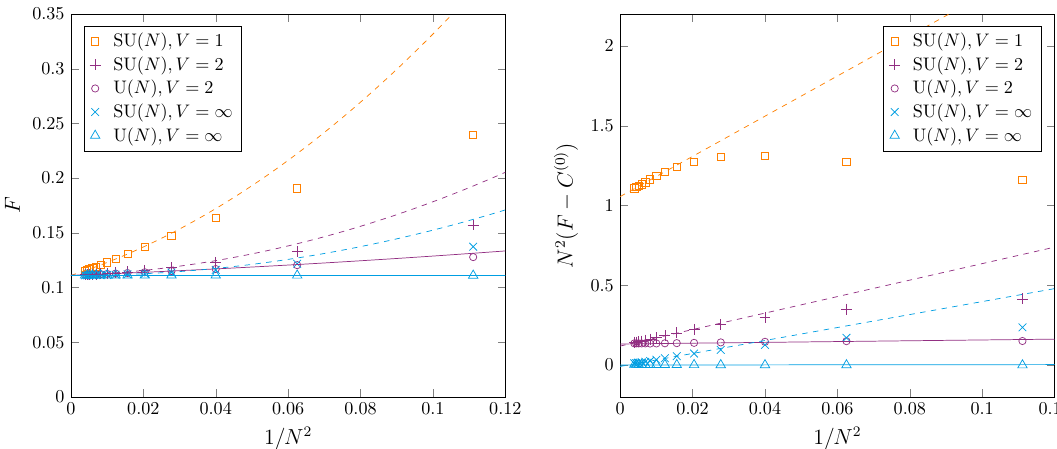
Figure 12 . (Left) The free energy density F is plotted against 1 /N 2 for the U( N ) and SU( N ) gauge theories at λ = 3 with V = 1 , 2 and ∞ using the bond dimension D cut = 64 . In the case of V = 1 , there is no distinction between U( N ) and SU( N ) gauge theories, so we plot only the results for the latter. The solid and dashed lines are fits to the function a + b/N 2 + c/N 4 for the U( N ) and SU( N ) gauge theories, respectively. (Right) The quantity N 2 ( F − C (0) ) is plotted against 1 /N 2 for the U( N ) and SU( N ) gauge theories at λ = 3 with V = 1 , 2 and ∞ using the bond dimension D cut = 64 . The solid and dashed lines are fits to the function a + b/N 2 for the U( N ) and SU( N ) gauge theories, respectively. The extrapolated values at N = ∞ give the coefficients of the O( 1 /N 2 ) terms in the free energy density F